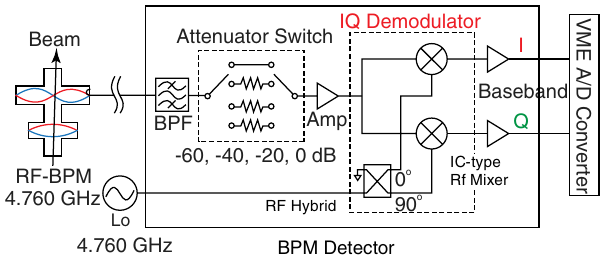
FIG. 4. Configuration of the BPM detector using the IQ demodulator.